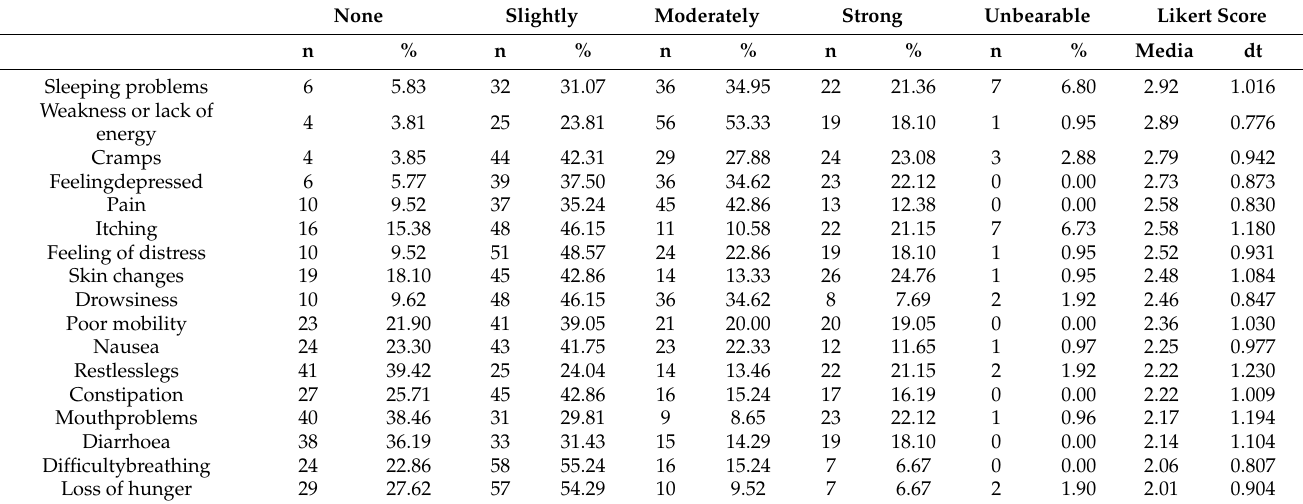
Table 3. Palliative Care Outcome Scale-Symptoms Scale Renal (POS-S Renal) Score.